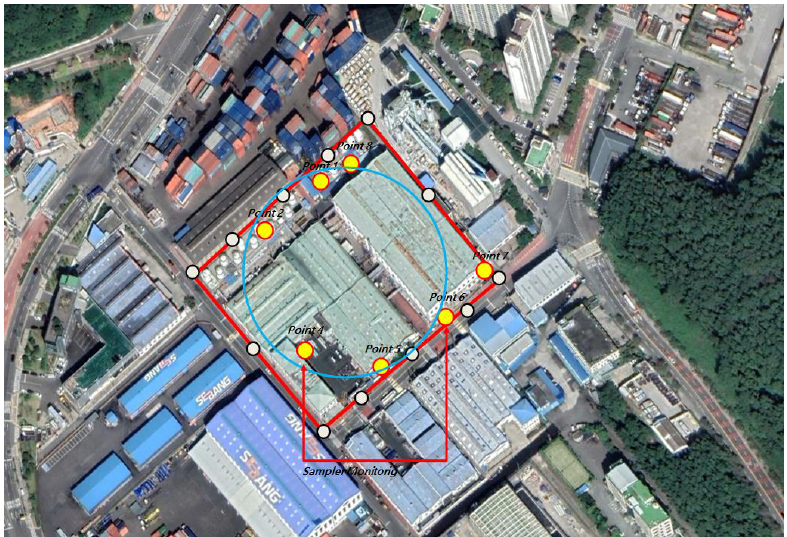
Figure 1. Linear approach: the regular shape of facilities (Paint Manufacturing business “A”).